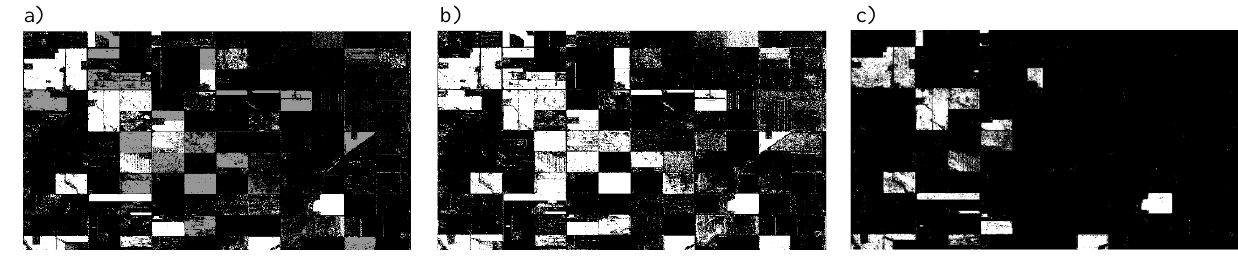
Figure 5. Change map resulted by proposed Mixture model (a) change map obtained by Kmeans model (b) change map obtained by Otsu model